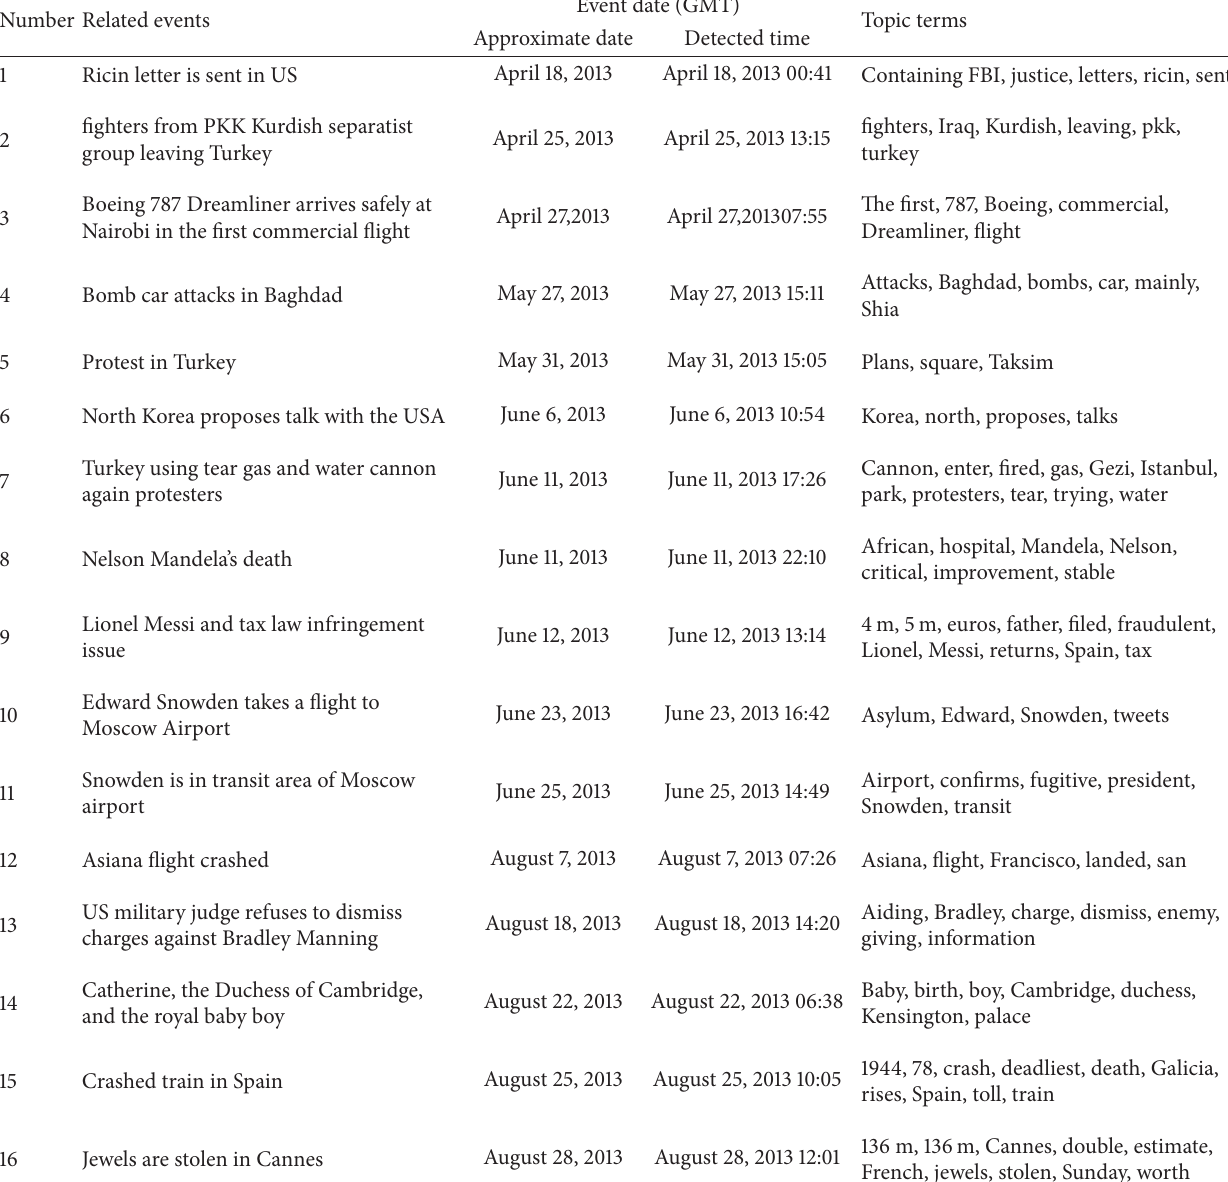
Table 1: List of detected events from BND data